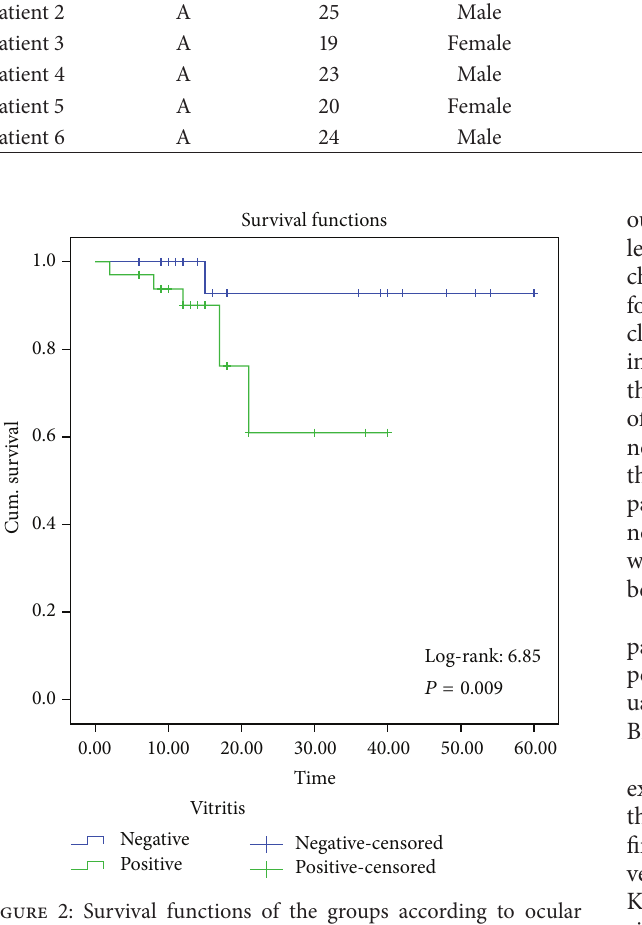
Figure 2: Survival functions of the groups according to ocular attack. Green line represents group A and blue line represents group B. A censored observation represents the end of their followup time for each patient. Steps at 2nd, 8th, 12th, 17th (binocular involvement), and 21st (binocular involvement) months in group A and 15th month (binocular involvement) in group B show individual ocular attacks. Also 60th and 40th months are the end of the last survived patients’ followup period for group A and group B,